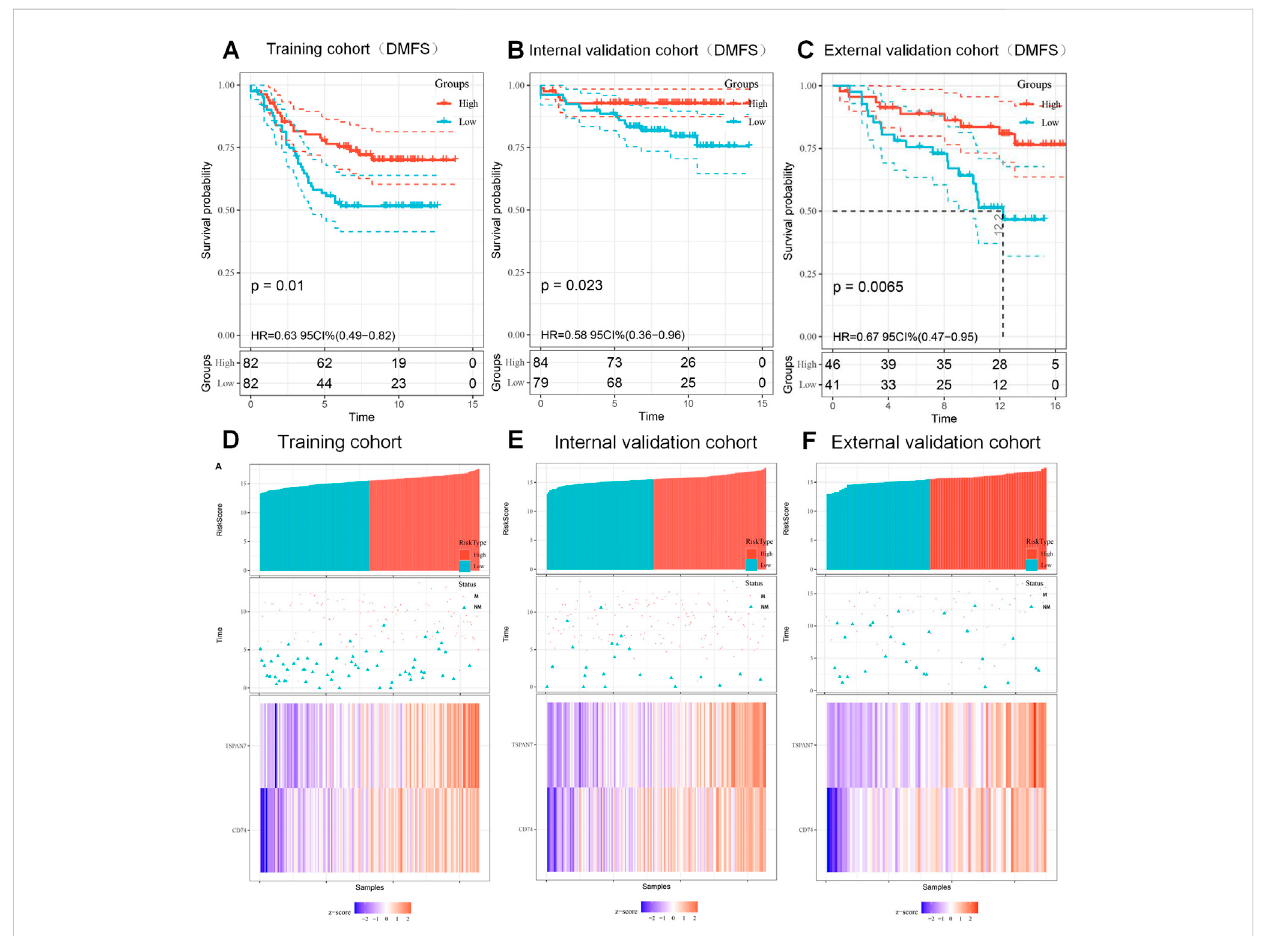
FIGURE 6 Kaplan-Meier curves of DMFS according to signature and the prognosis of patients with BC. (A – C) Kaplan-Meier curves of DMFS based on the signature (15.488) in training cohort (A) , internal validation cohort (B) and external validation cohort (C) . (D – F) The distribution of risk score (top), metastatic status (middle) and expression heatmap (bottom) of the two biomarkers in training cohort (D) , internal validation cohort (E) and external validation cohort (F) . M, metastasized; NM,